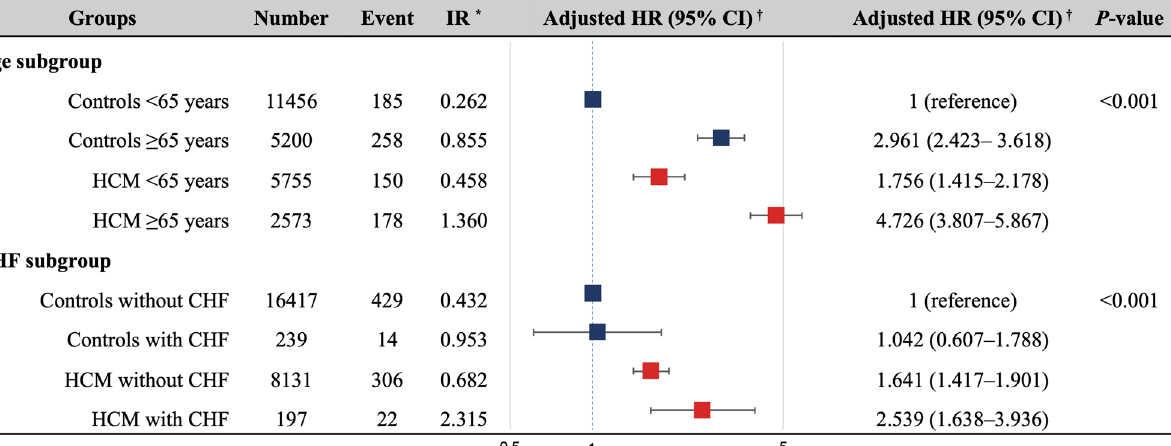
Figure 3. Incidence rate and adjusted hazard ratio of ischemic stroke. Incidence rate and adjusted hazard ratio of ischemic stroke in the hypertrophic cardiomyopathy (HCM) and control groups according to age and chronic heart failure (CHF). The overall incidence rate of ischemic stroke was 1.36 per 100 person-years and 2.32 per100 person-years in patients with HCM aged ≥ 65 years and those with CHF, respectively. Besides, the adjusted hazard ratio (HR) for ischemic stroke was 4.7 and 2.5 in patients with HCM aged ≥ 65 years and those with CHF, respectively. *Incidence rate (IR) was presented as 100 person-years. † Adjustment for age, sex, low income, CHF, hypertension, diabetes mellitus, dyslipidemia, vascular disease (including myocardial infarction and peripheral artery disease), and pacemaker implantation. CI, confidence